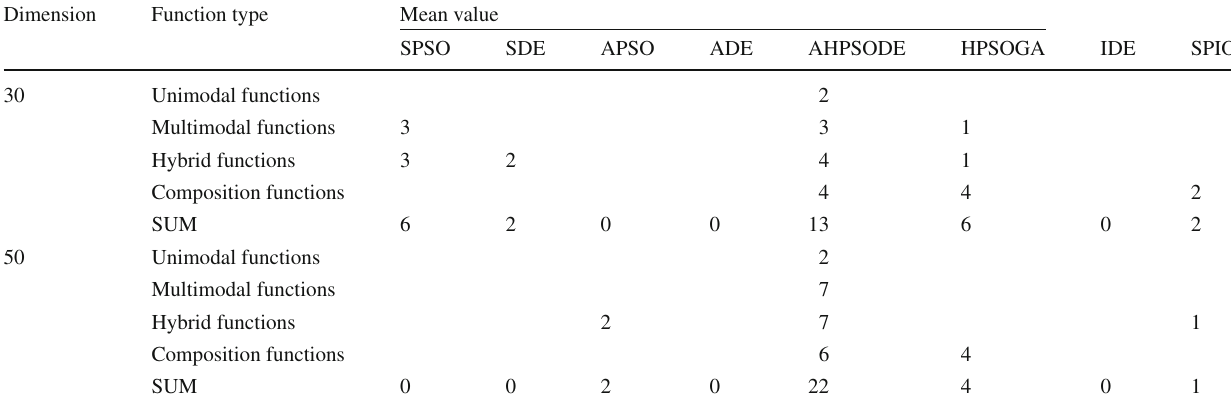
Table 4 Statistics of mean value for AHPSODE and compared algorithms on CEC 2017 Dimension Function type